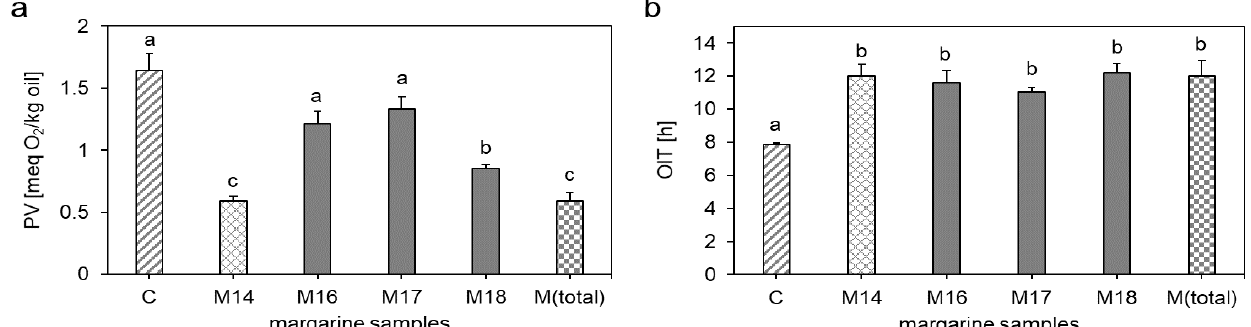
Figure 4. Influence of minor components on the oxidative stability of margarine determined by the peroxide value ( a ) and oxidation induction time ( b ). M1 was used as control (C, 1.64 meq O 2 /kg oil ( a ), 7.86 h ( b )). M14 represents the margarine without minor components using E1 and 0.160% GTE. Individual components were added to M14. Citric acid was added as minor component in M16, β -carotene in M17 and NaCl in M18. All minor ingredients were added in M(total). Data are depicted as mean + SD (n = 4). Statistically significant differences between the margarine samples are indicated with different lower-case letters (one-way ANOVA, Holm–Sidak, p < 0.05).